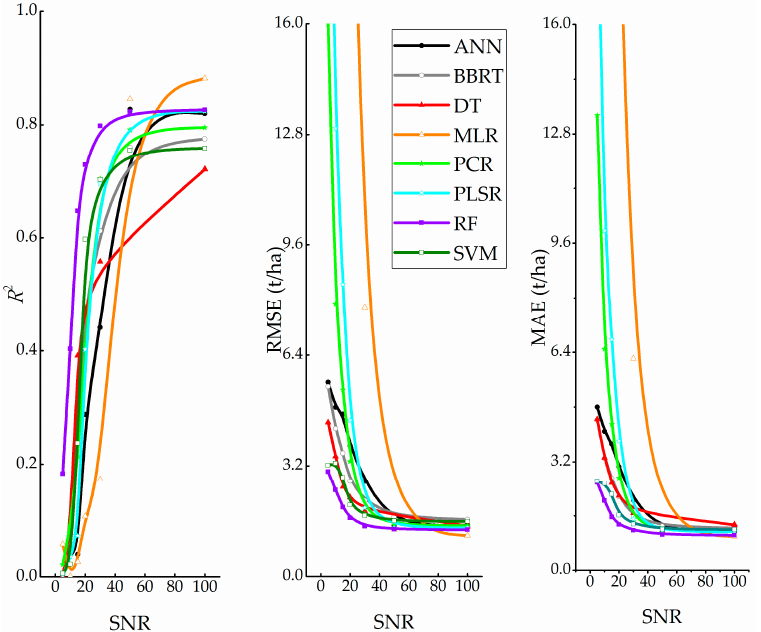
Figure 7. Three measures of accuracy as a function of the signal-to-noise ratio. Note: SNR 100 represents no noise. All techniques used the first 30 sets of VIs (Table 4) as the input, with SNR = 5, 10, 15, 20, 30, 50, and no noise.